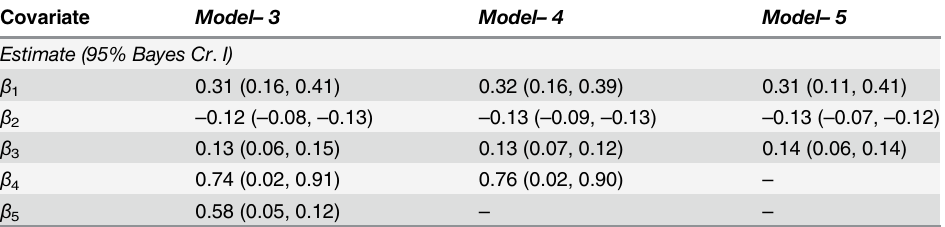
Table 5. Model statistics for Bayesian spatio – temporal covariate models evaluating county – level RMSF prevalence in four central Midwestern states (Kansas, Missouri, Arkansas, Oklahoma), United States of